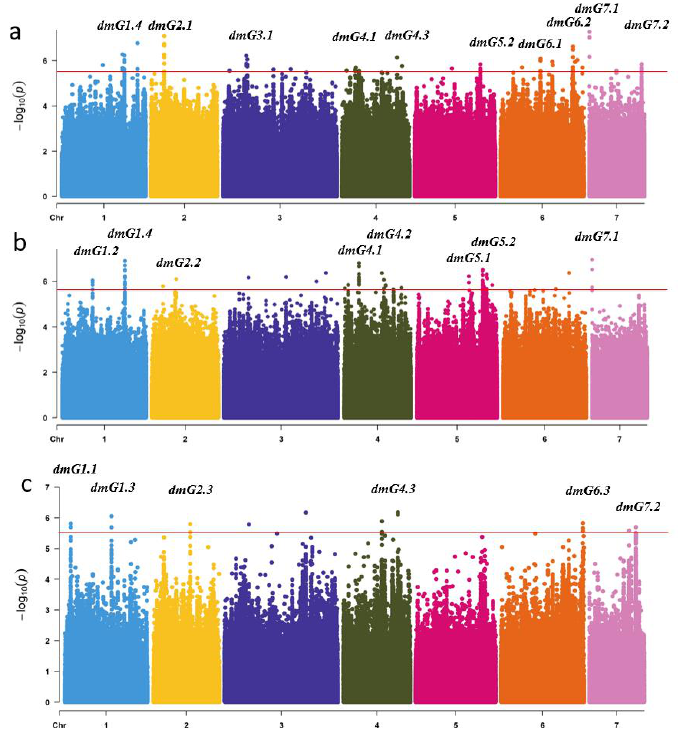
Figure 3. Genome-wide association analysis (GWAS) Manhattan plots of downy mildew (DM) resistance in three experiments, and the distribution of 97 cucumber CG lines in di ff erent continents based on DI of DM resistance. Bonferroni significance threshold of GWAS ( p < 3.15 × 10 − 6 ). ( a ) dm_2014A; ( b ) dm_2014S; ( c ) dm_2015A.